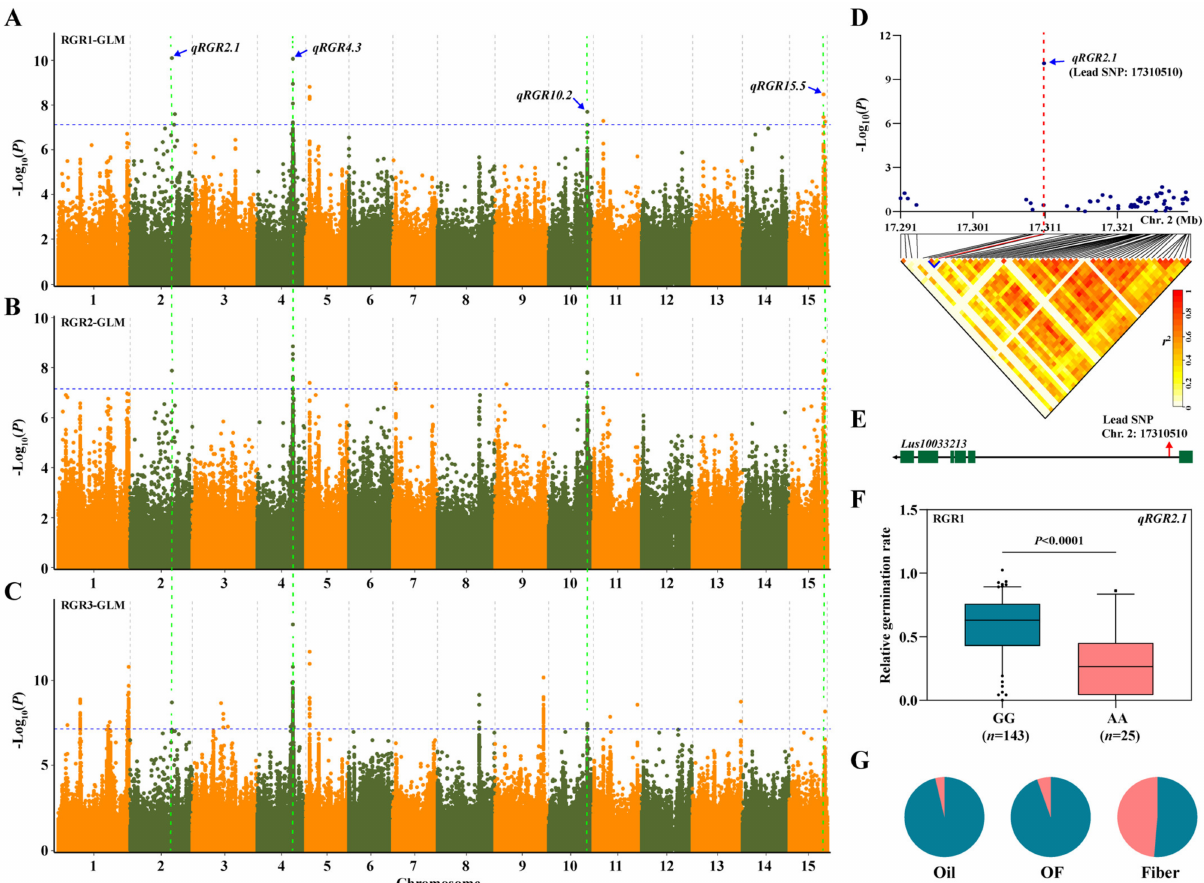
Figure 5. GWAS for RGR traits, and candidate genes were obtained for the peak region on chromo- some 2. ( A – C ) Manhattan plots based on GLM; ( A ) RGR1; ( B ) RGR2; ( C ) RGR3. The horizontal blue dotted line indicates the threshold, and the points above the threshold are significant SNPs. The point indicated by the blue arrow is the lead SNP in the repeatedly detected QTLs; ( D ) Local Manhattan plot (top) and LD heatmap (bottom) surrounding the peak on chromosome 2. The blue arrow indicates a significant SNP (Lead SNP: 17310510) in qRGR2.3; ( E ) Gene structure of Lus10033213; ( F ) Boxplot for haplotypes based on the lead SNP in qRGR2.3; ( G ) The distribution of allele frequencies of strong SNP are located in qRGR2.3 which was distributed in Oil, OF and Fiber subpopulations. The GG and AA alleles are shown in blue and pink, respectively. The difference between haplotypes was analyzed by t